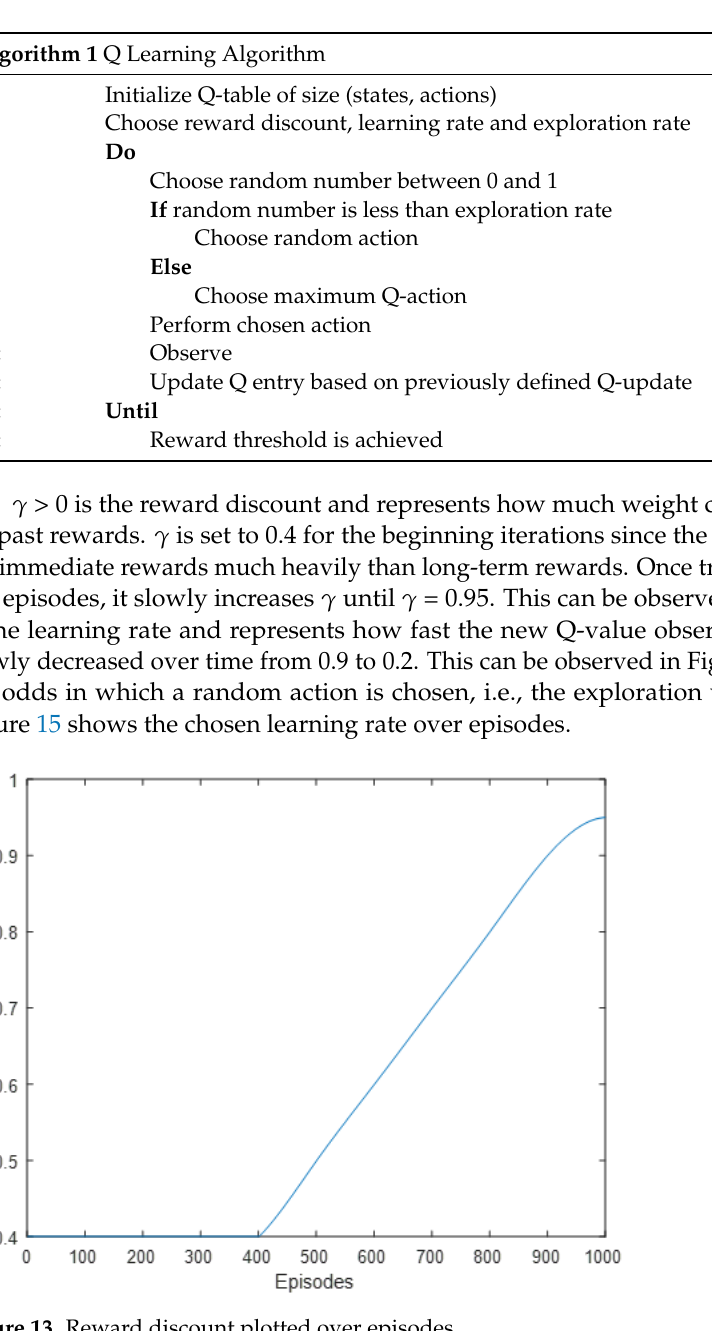
Figure 14. Learning rate plotted over episodes.